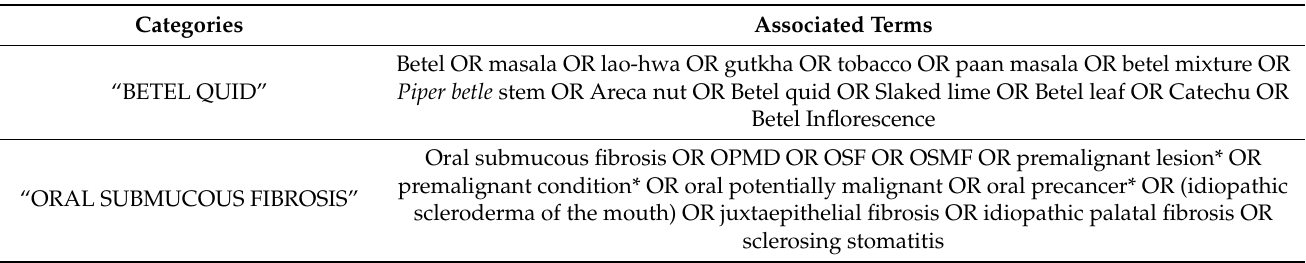
Table 1. Search terms used for this